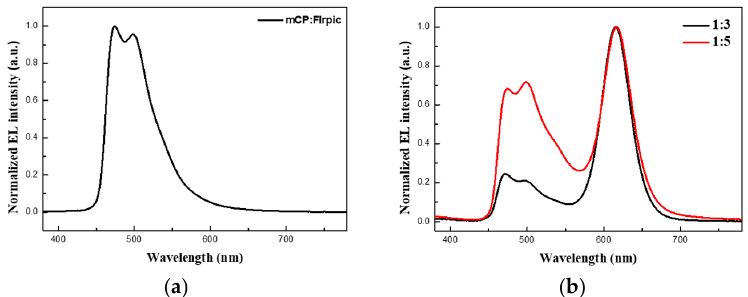
Figure 3. EL spectra of ( a ) the monochromatic EL device with only 1,3-Bis(N-carbazolyl)benzene (mCP):Bis[2-(4,6-difluorophenyl)pyridinato-C2,N](picolinato) iridium(III) (FIrpic) and ( b ) the bichromatic hybrid EL device with mixed EMLs at 10 V.